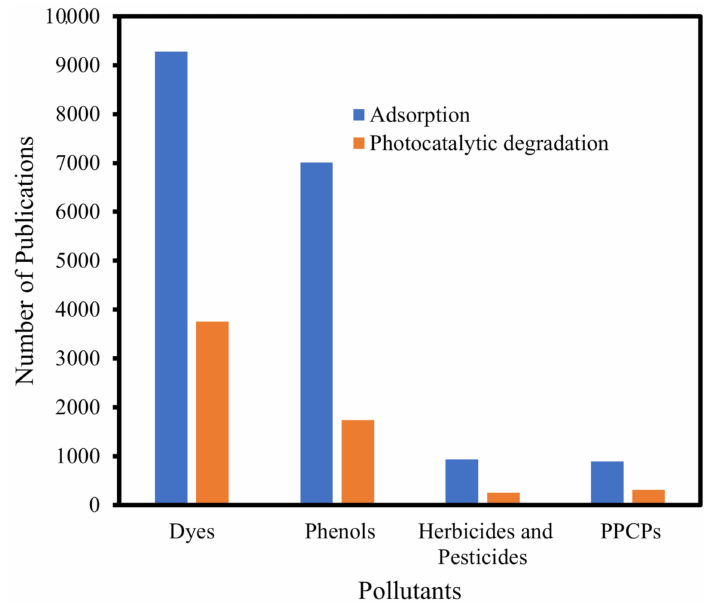
Figure 3. Publications on the adsorption and photocatalytic degradation of some emerging pollutants using MOFs from 2010–2020. Data were obtained from science direct using the keywords; MOFs; adsorption; photocatalytic degradations; dyes, phenols; pesticides and herbicides; and pharmaceuticals and personal care products